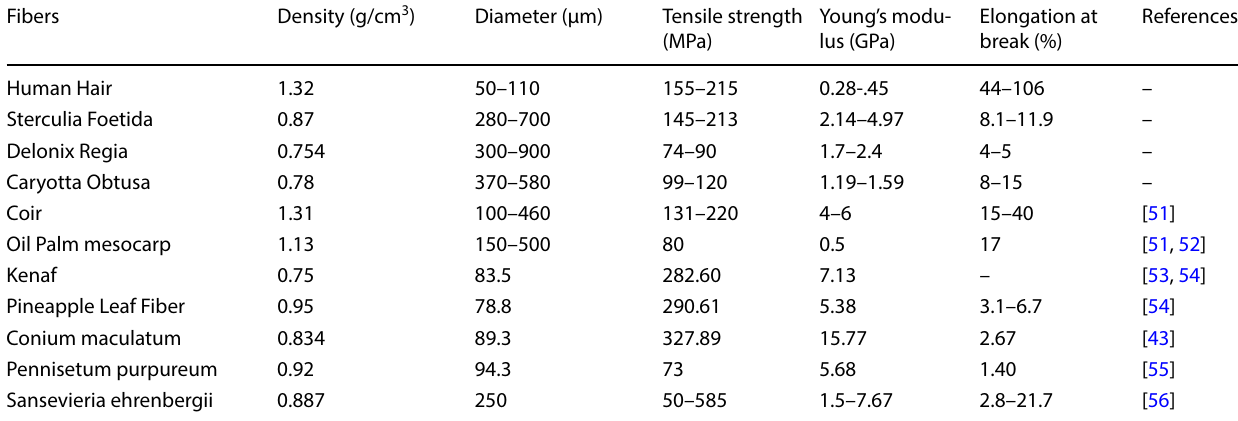
Fig. 9 Young’s modulus of untreated and treated natural